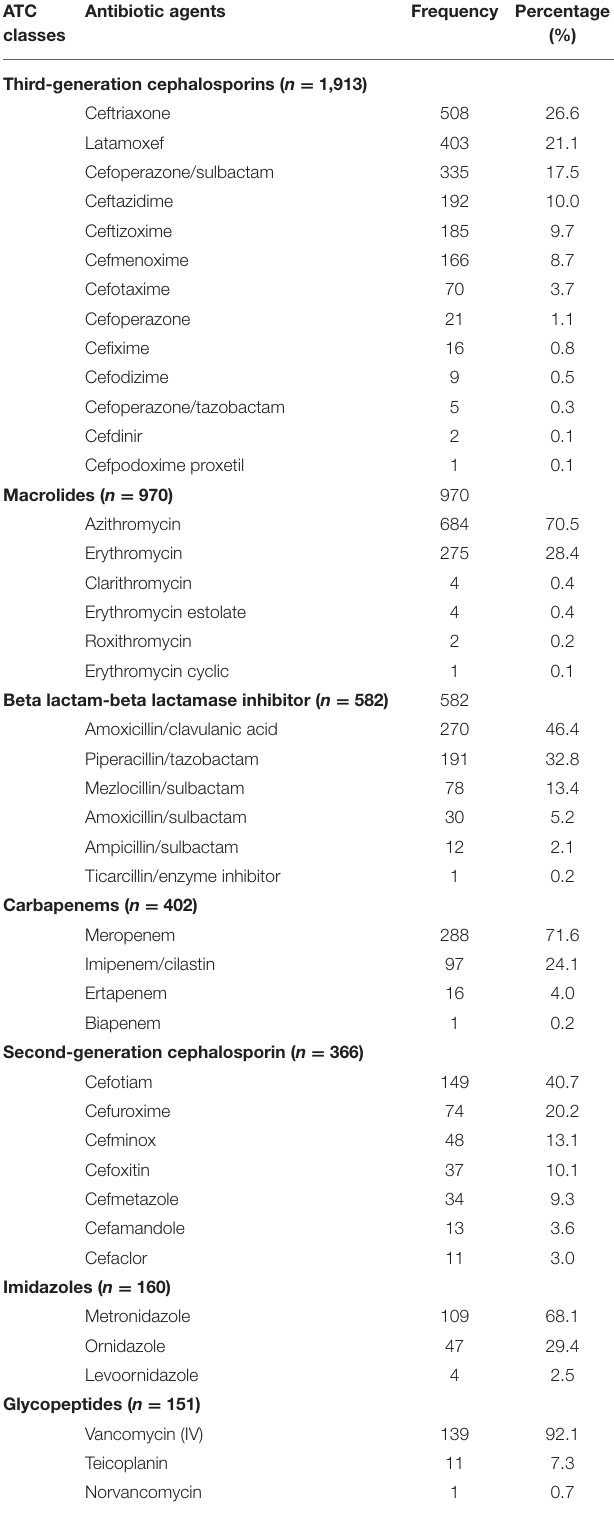
TABLE 3 | Patterns of 4,982 antibiotic prescriptions for Chinese children by drug utilization 90% according to the ATC classification. ATC Antibiotic classes